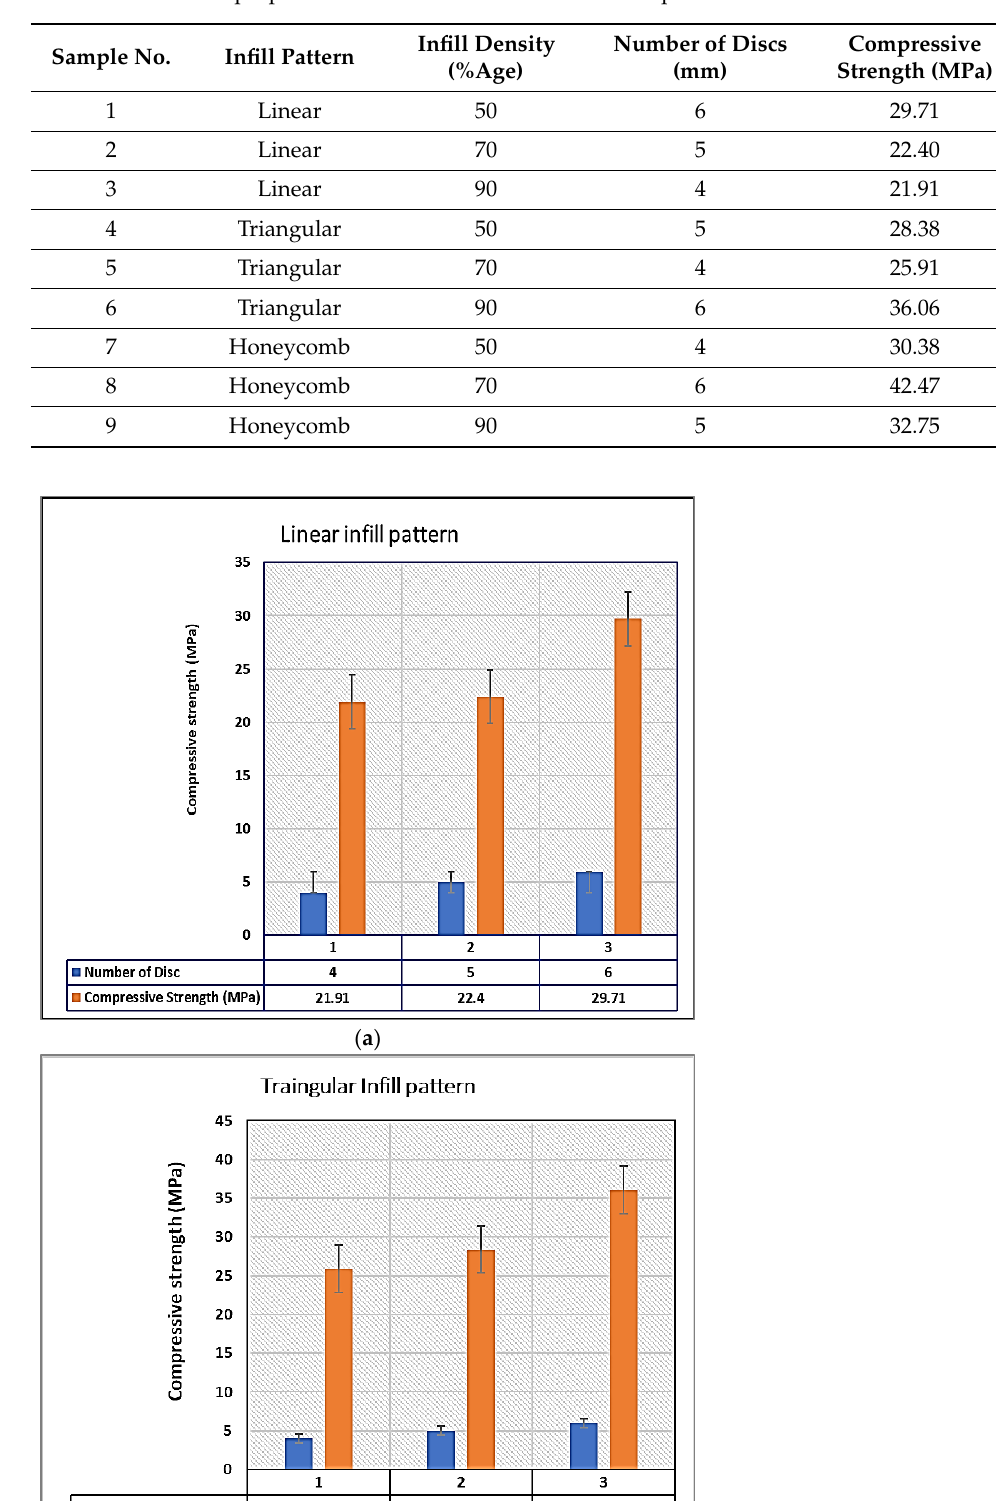
Table 5. Mechanical properties of LOM manufactured PLA samples.